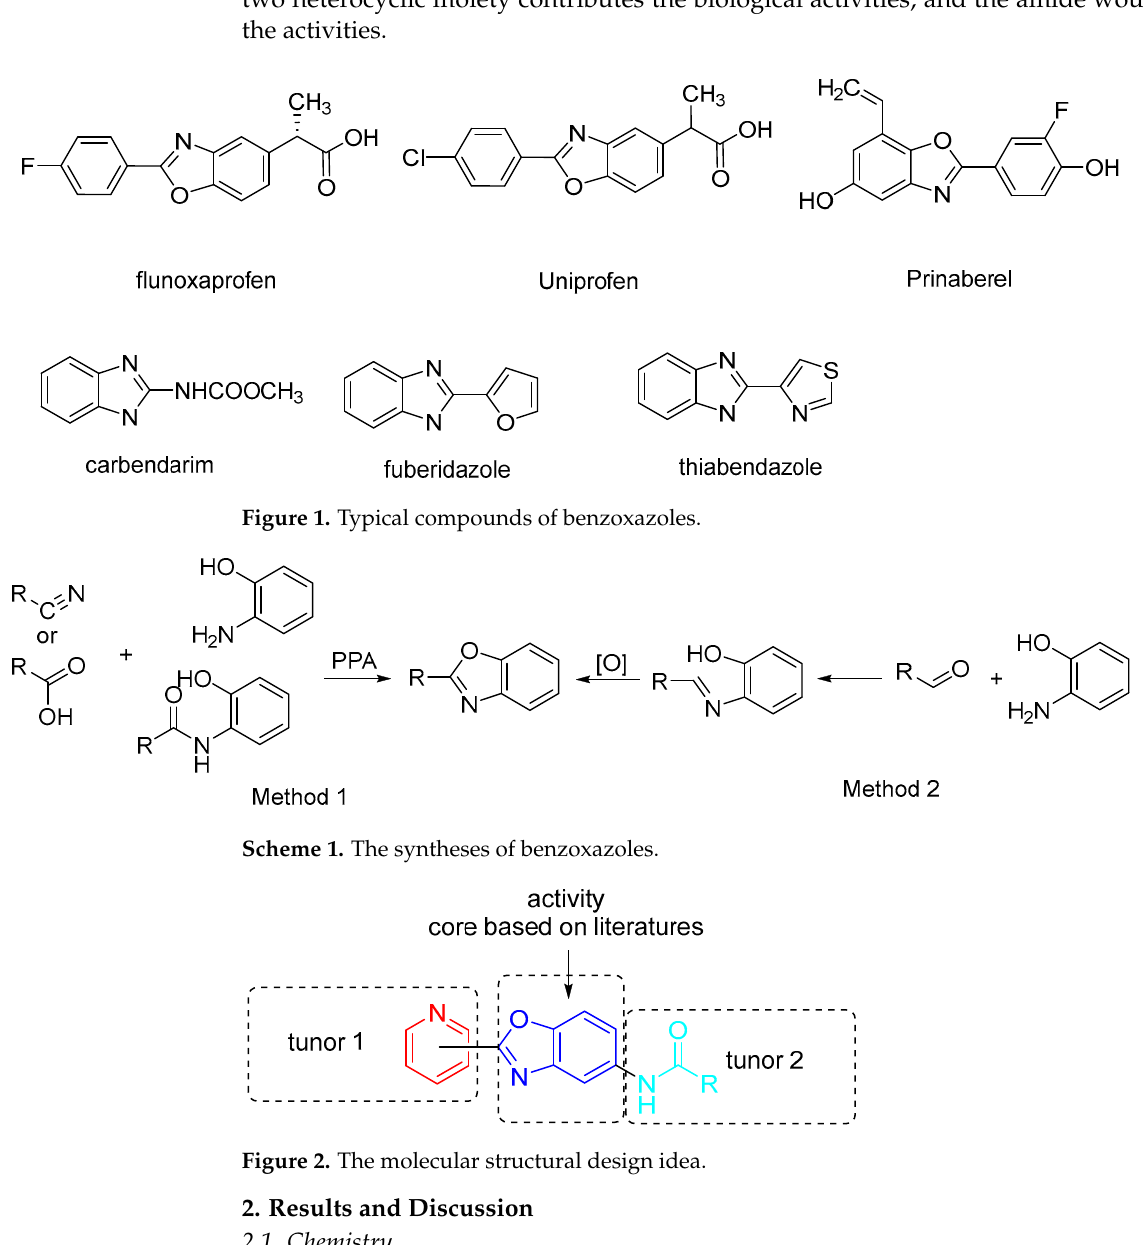
Figure 1. Typical compounds of benzoxazoles.